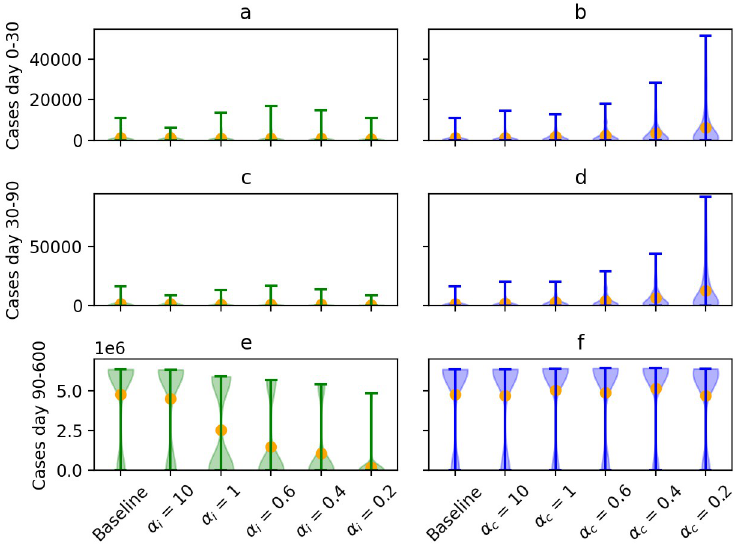
Fig 6. Violin plots for the number of cases before lockdown (day 0–day 30), during lockdown (day 30–day 90) and during partial release phase (day 90–day 600) for the different scenarios investigating infectiousness-related heterogeneity (in green, panels a, c, and e, respectively) and contact-related heterogeneity (in blue, panels b, d, and f, respectively). The orange dots represent the mean of the simulated